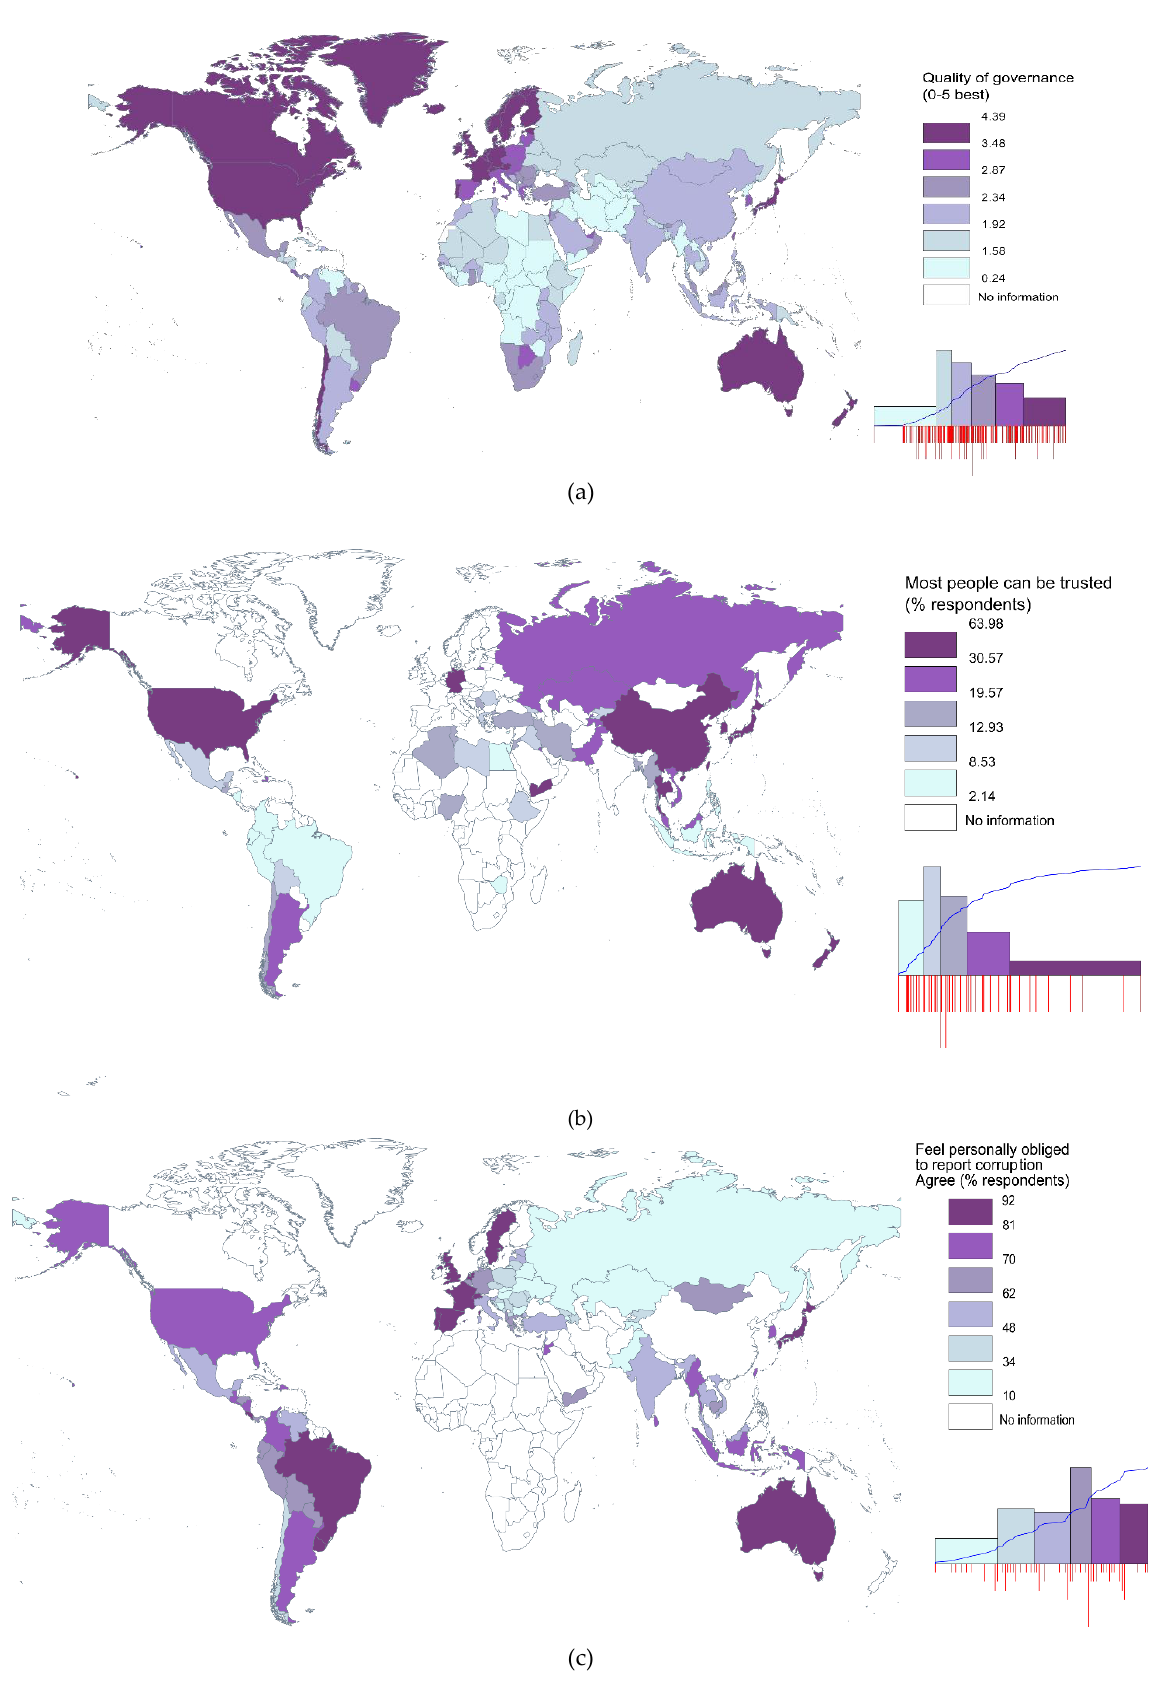
Figure A1. The relation between informal payments in health and informal institutions. ( a ) The relation between informal payments in health and social trust. Source : Authors’ representation using data from Transpa rency International and World Value Survey. ( b ) The relation between informal payments in health and the personal engagement in reporting corruption. Source : Authors’ representation using data from Transparency International.